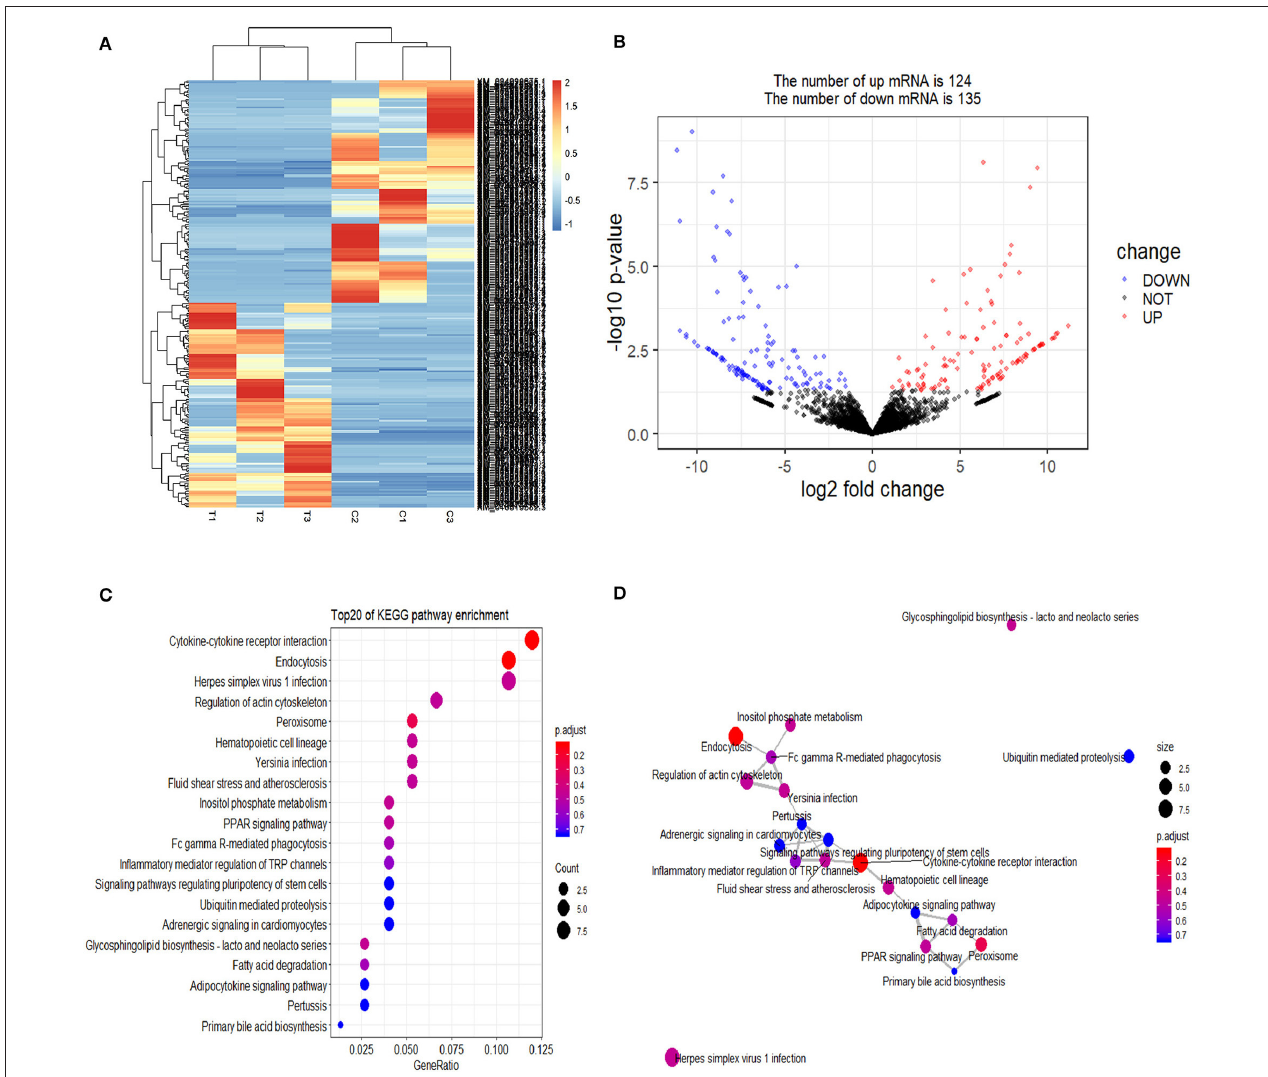
FIGURE 1 | Screening and enrichment analysis of differently expressed mRNAs (DEmRNAs) in S. aureus infected mammary epithelial cells compared with non-infected mammary epithelial cells. (A) Cluster analysis of DEmRNAs in mammary epithelial cells between the control group (C1, C2, and C3) and treatment group (T1, T2, and T3). Red indicates highly expressed genes, and blue indicates low expressed genes. Each column represents a sample, and each row represents a gene. On the left is the tree diagram of mRNA clustering, and on the right is the name of each mRNA. The closer the two mRNA branches are, the closer their expression level is. The upper part is the tree diagram of sample clustering, and the bottom is the name of each sample. The closer the two-sample branches are to each other, the closer the expression pattern of all genes in the two samples are and the trend of the more recent gene expression. (B) Volcano plot of global DEmRNAs in mammary epithelial cells between the control group and treatment group. Red dots (Up) represent significantly up-regulated genes [ P < 0.05, | log2(fold-change) | > 1]; blue dots (Down) represent significantly down-regulated genes [ P < 0.05, log2(fold-change) < − 1]; black dots represent insignificantly differential